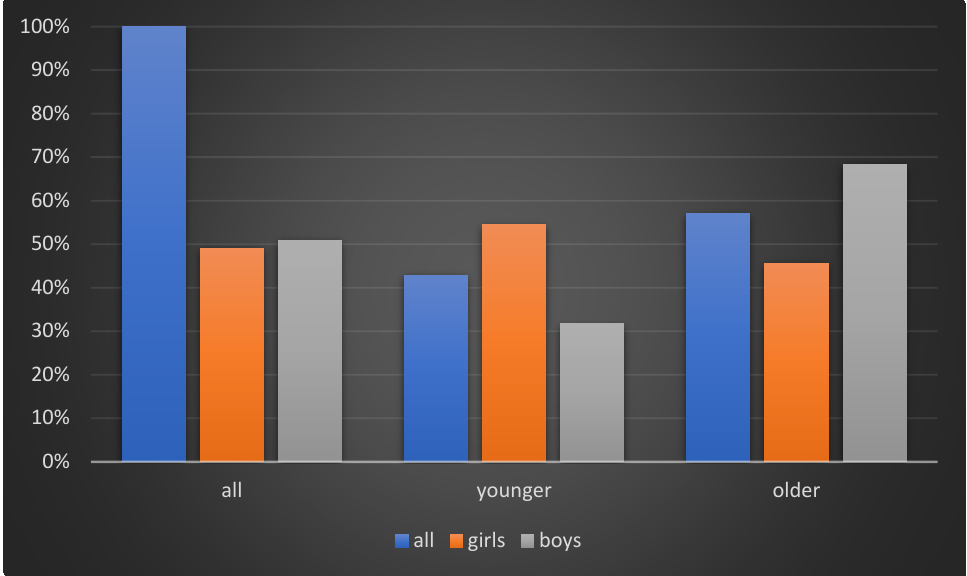
Figure 1. Histogram of the percentage of children in examined group with sex division.